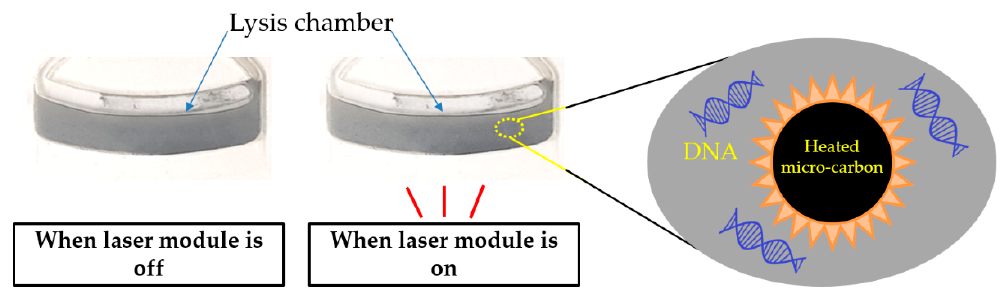
Figure 6. Micro-carbon-activated cell lysis. The micro-carbon absorbs a laser beam with high efficiency; subsequently, the DNA molecules are released from the heated cells when the laser module is on.